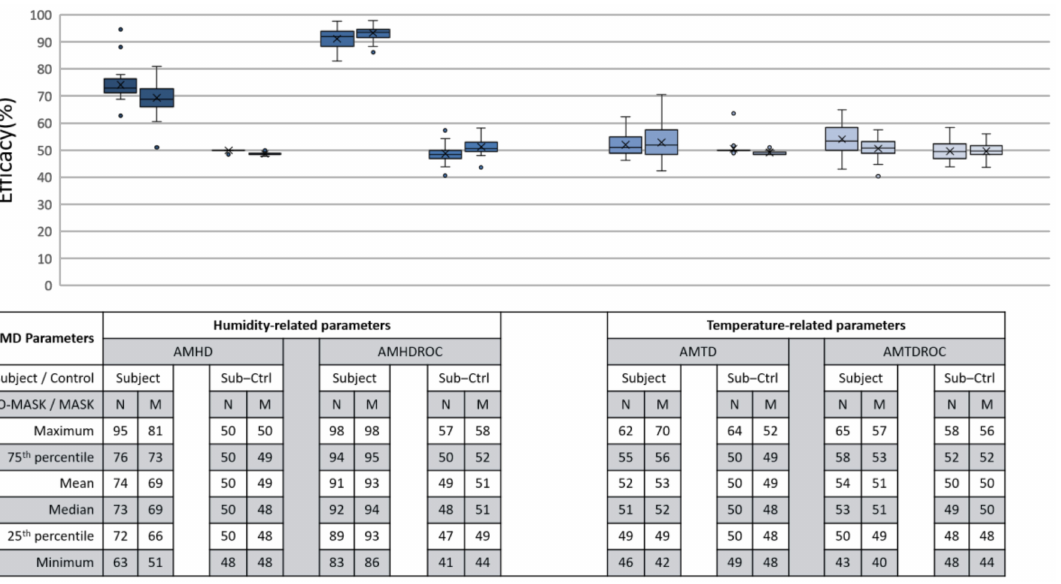
Figure 16. Efficacy between subject (S) and subject-control (SC) groups during continuous monitoring. Each box contains 30 respective entries. AMHD (leftmost) demonstrated clear distinction between S and SC